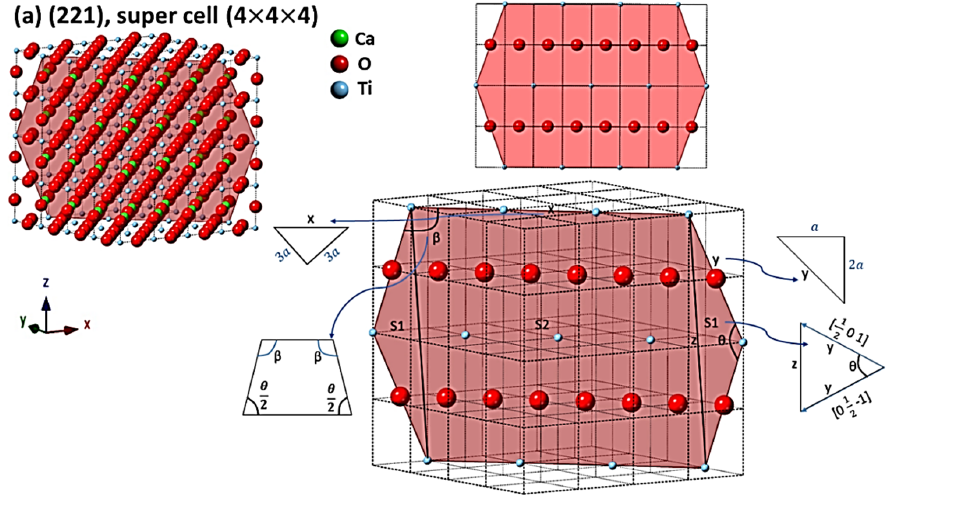
Figure 3. Geometry of planes and calculations of planar density of ( a ) (211) super cell (4 × 4 × 4) and ( b ) (211) super cell (8 × 8 × 8) (which shows and emphasizes the symmetry of (8 × 8 × 8) super cells).